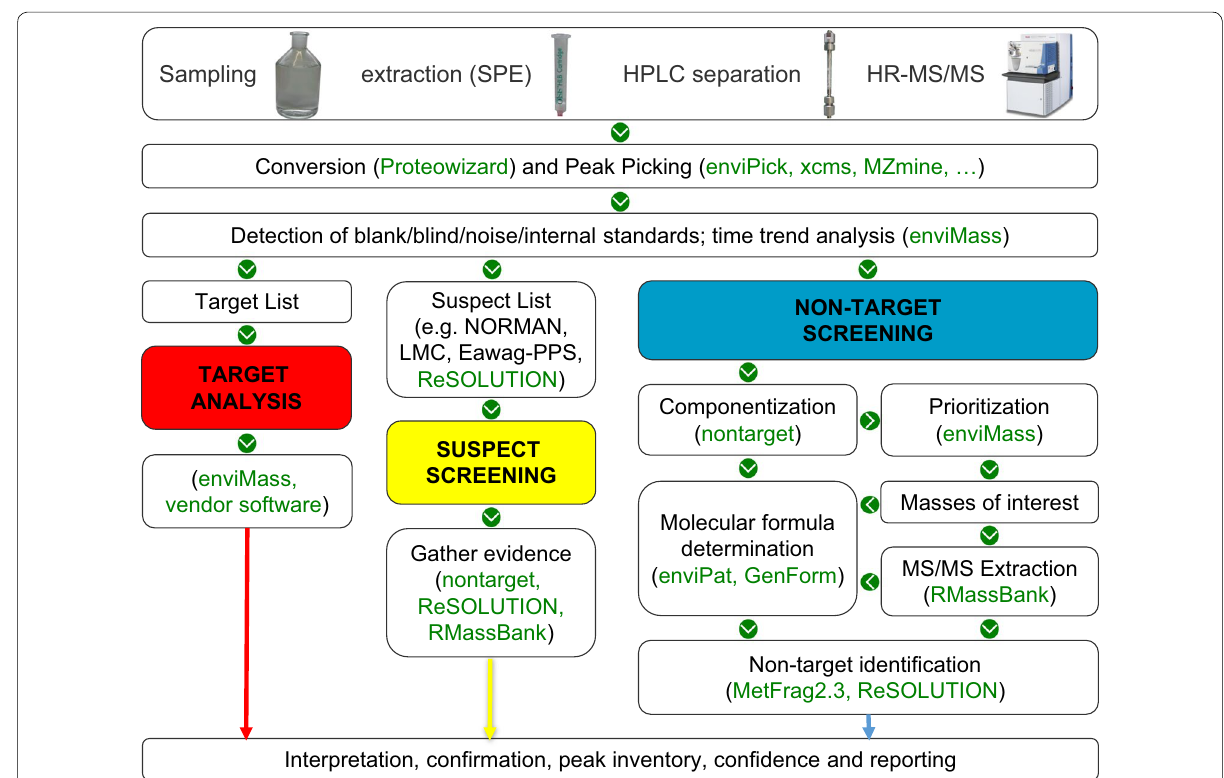
Fig. 2 The SOLUTIONS workflow for structure assignment in target, suspect and non‑target analysis (Source: https ://solut ions.marvi n.vito.be/docs/ produ cts_endus er/FS003